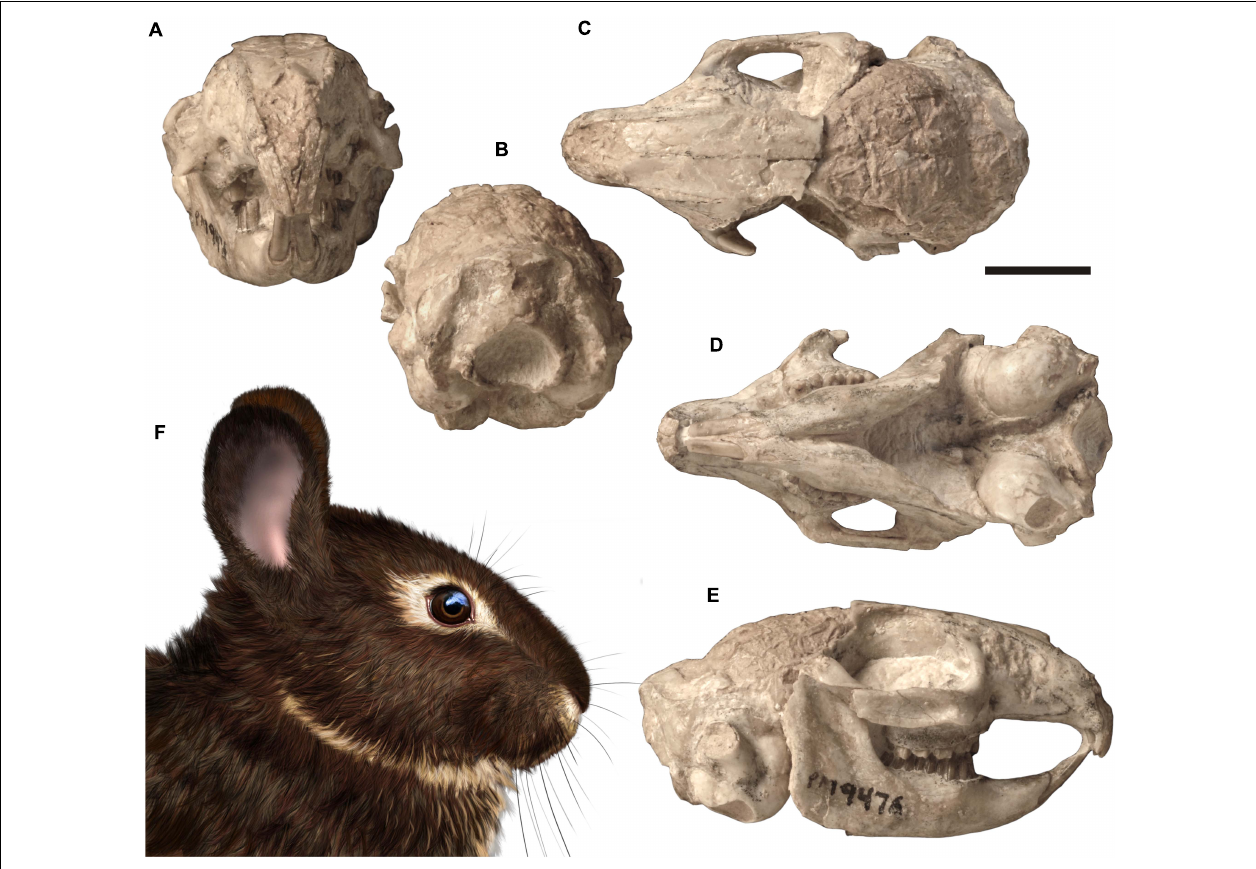
FIGURE 1 | Skull of Palaeolagus haydeni (FMNH PM9476) from the early Oligocene of Nebraska in (A) anterior, (B) posterior, (C) dorsal, (D) ventral, and (E) right lateral views. Life reconstruction (F) of the head of Palaeolagus drawn by A. Kapu´sci´nska. Scale bar = 10